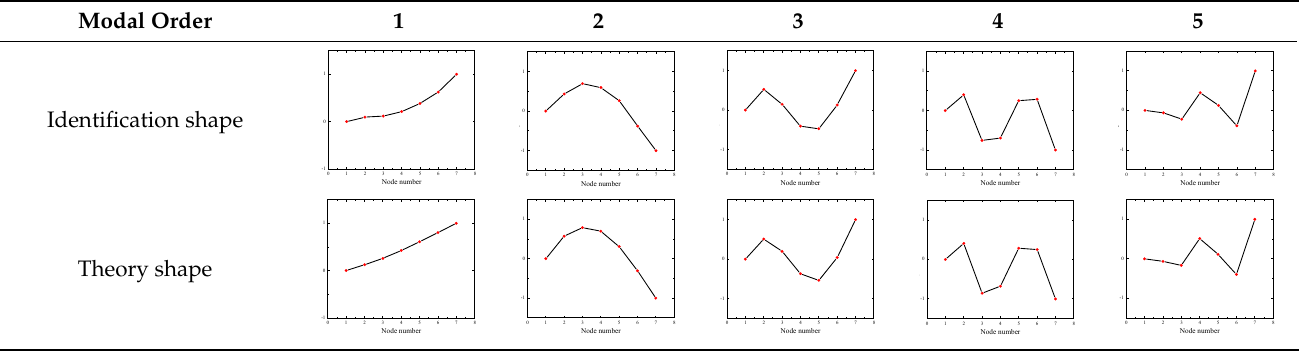
Table 6. Comparison of identification frequency.